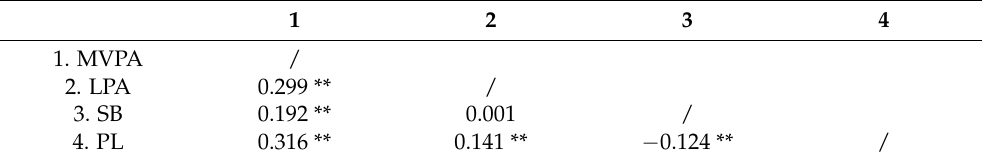
Table 4. Correlation Analysis of variables ( n = 2996).